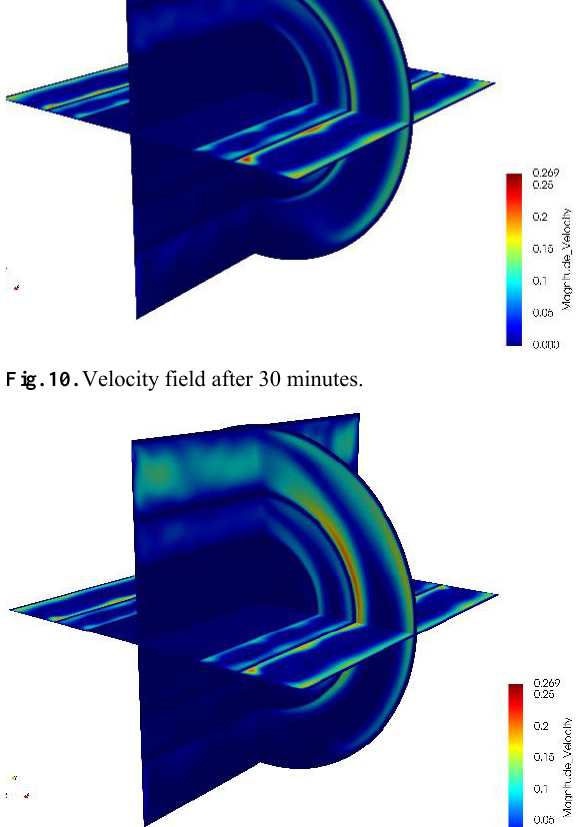
Fig. 11. Velocity field after 45 minutes .